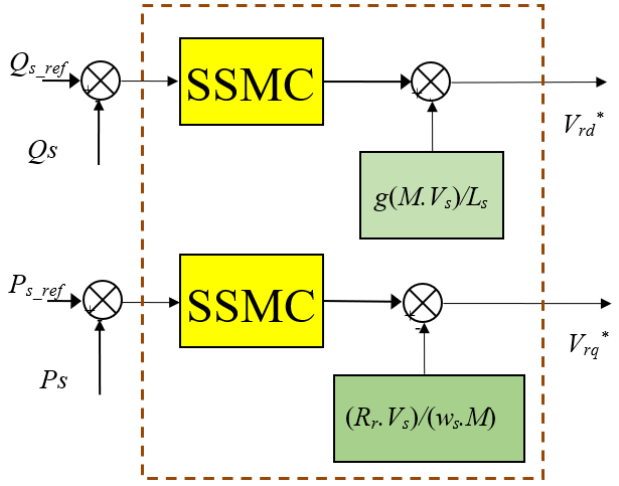
Figure 4. Structure of the direct FOC-SSMC technique.